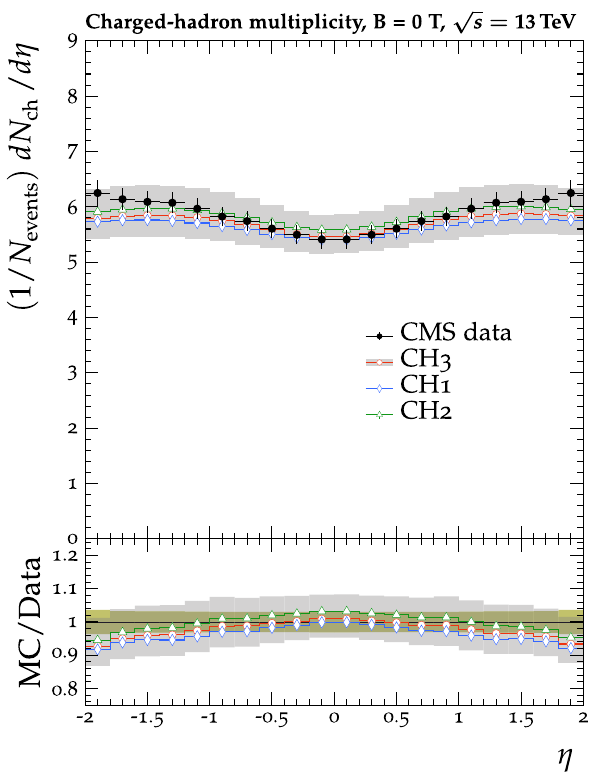
Fig. 10 Thenormalizedd N ch / d η ofchargedhadronsasafunctionof η [27]. CMS MB data are compared with the predictions from herwig 7, with the CH tunes. The coloured band in the ratio plot represents the totalexperimentaluncertaintyinthedata.Theverticalbarsonthepoints for the different predictions represent the statistical uncertainties. The grey-shaded band corresponds to the envelope of the “up” and “down” variations of the CH3 tune